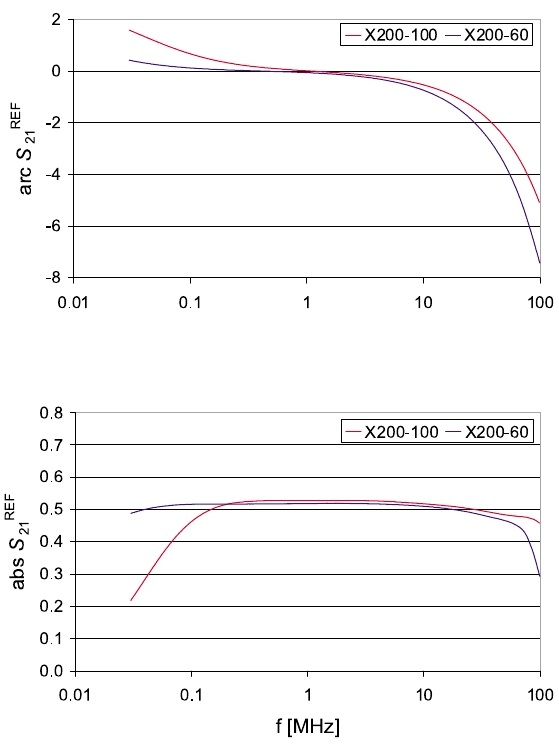
FIG. 6. (Color) Reference beam tube impedance versus free